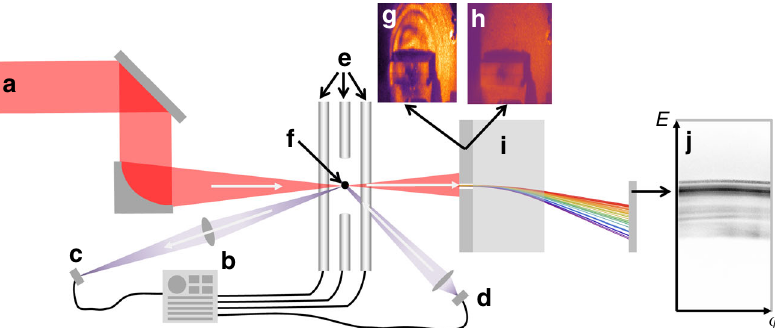
Fig. 4 Schematic overview of the experimental setup. a Incoming PHELIX laser beam, b Paul trap power supply, c 660 nm illumination laser, d electro- optical diagnostic for target damping and positioning, e Paul trap electrodes, f trapped target scatter screen for transmitted light with g and without h target, i magnetic spectrometer, j IP raw proton/ion data (without